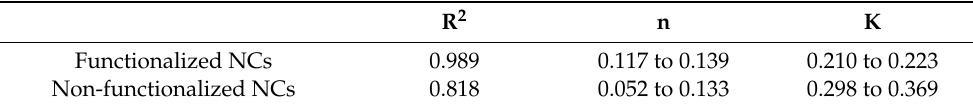
Table 3. Power law parameters (n, K) and fitting accuracy R 2 for DNA release from functionalized and non-functionalized